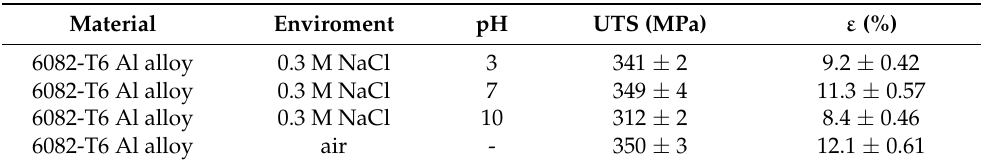
Figure 3. Effect of the pH of 0.3 M NaCl solution on the stress-strain curves of T6 treated 6082 aluminum alloy, obtained from the slow strain rate test (SSRT). Table 1. Effect of the pH of 0.3 M NaCl solution on the ultimate tensile strength and ductility of T6 treated 6082 aluminum alloy.